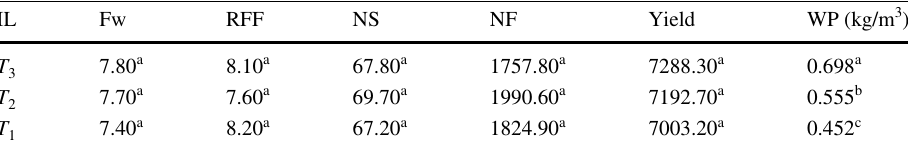
IL Irrigation levels of SDI system Values with a common superscript in each column indicate no significant